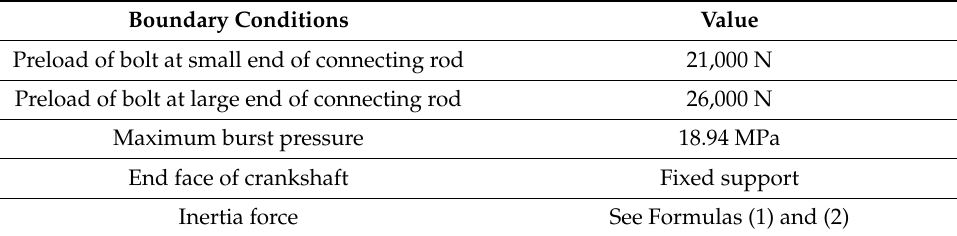
Table 4. Setting of boundary conditions in simulation calculation of connecting rod